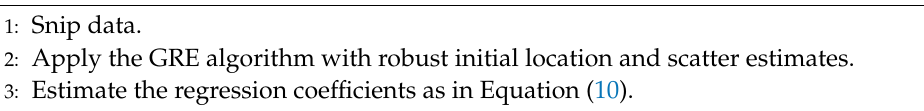
Algorithm 3 Computation of 3S-regression and C3S-regression